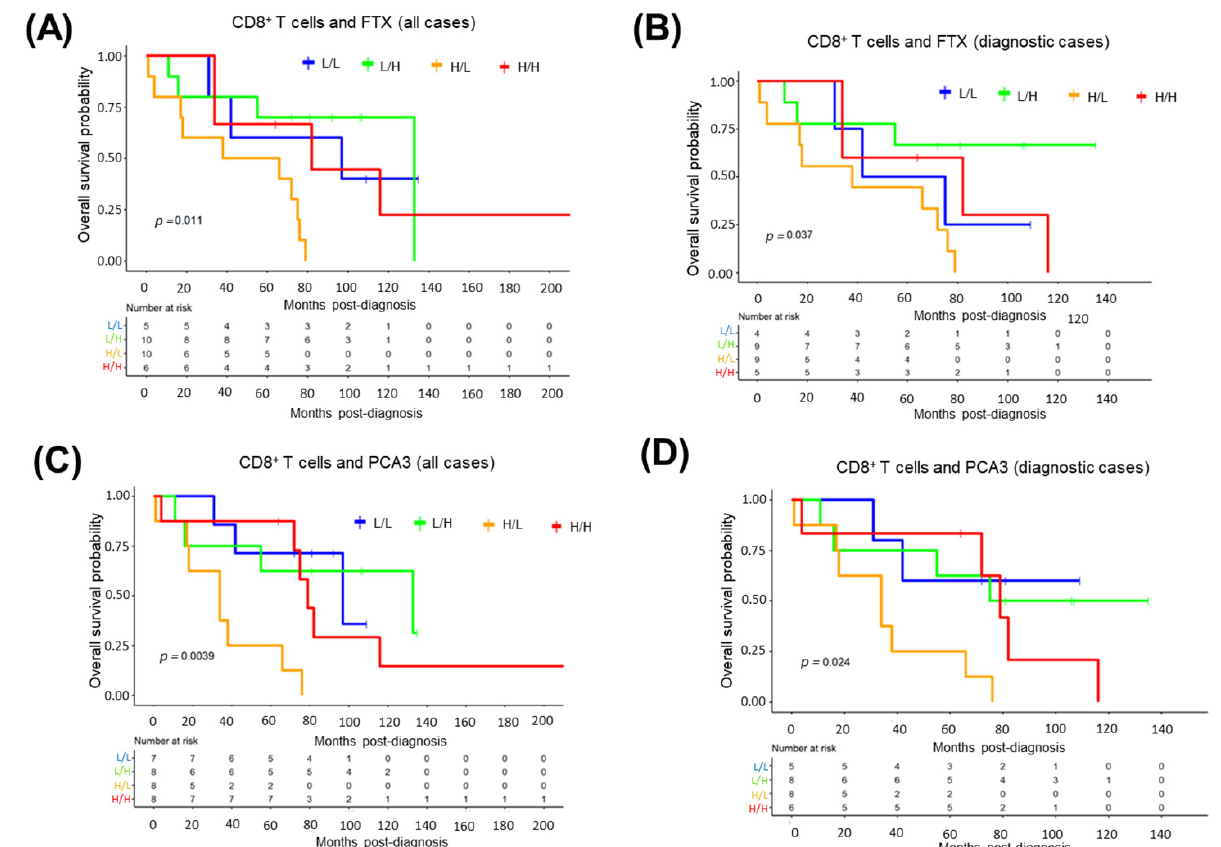
Figure 11. High tumor-infiltrating CD8 + T-cell ratio together with low FTX or PCA3 expression predicts high-risk MCL patients. Kaplan–Meier plots showing the curves based on a combination of tumor-infiltrating CD8 + T-cell ratios and FTX ( A , B ) or PCA3 ( C , D ) transcript expression levels. L/L: Low CD8 + T-cell abundance and low transcript expression; L/H: Low CD8 + T-cell abundance and high transcript expression; H/L: High CD8 + T-cell abundance and low transcript expression; H/H: High CD8 + T-cell abundance and high transcript expression.